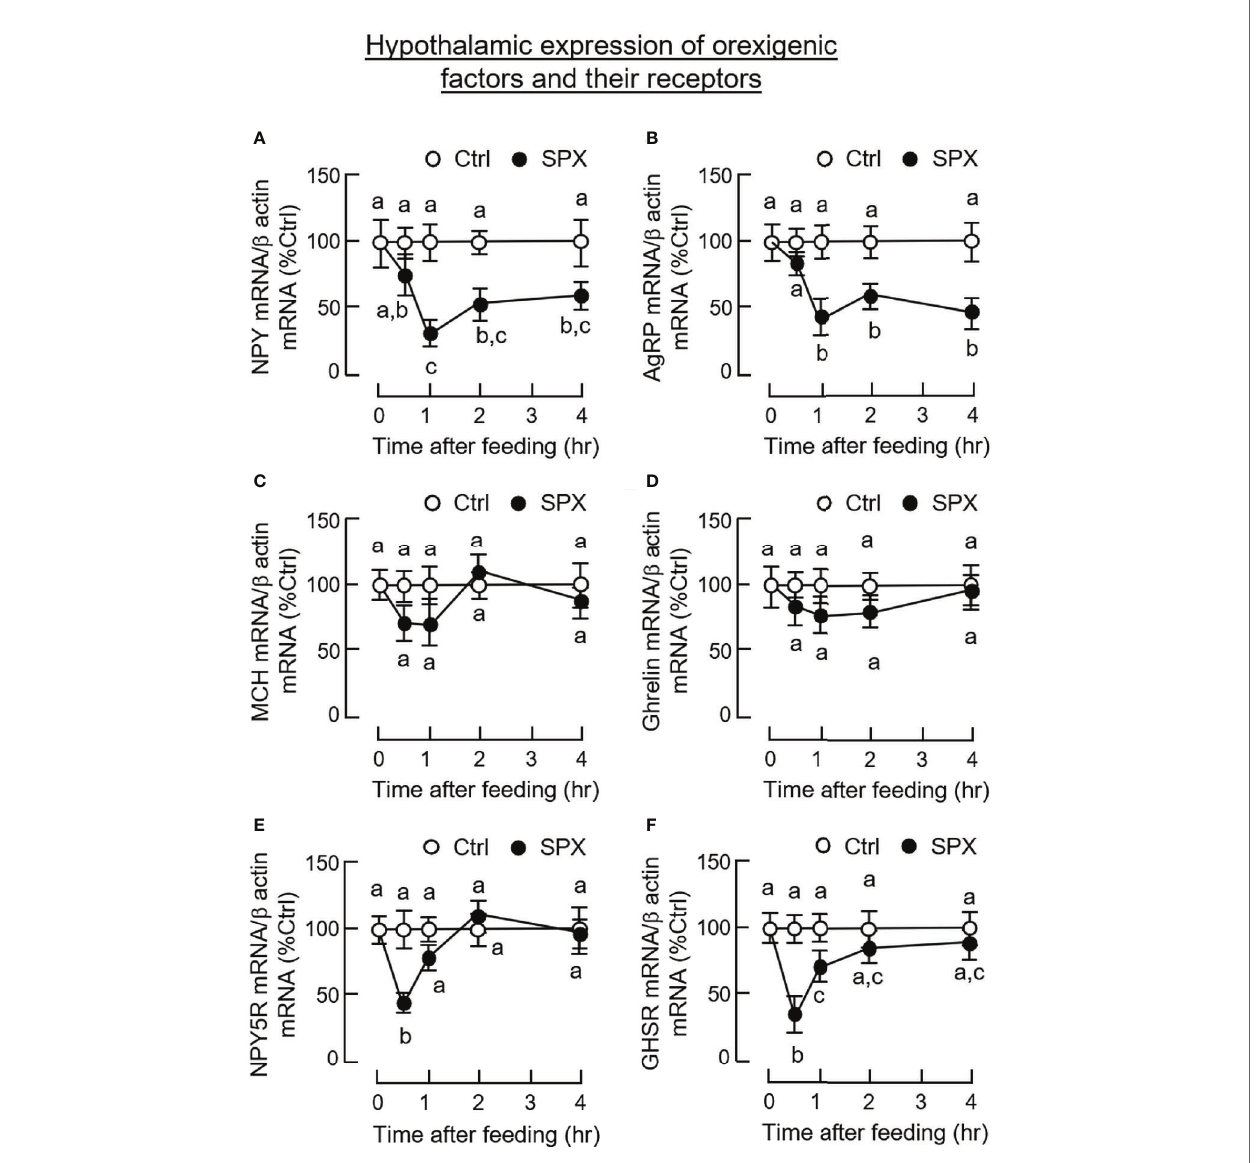
FIGURE 7 | Central administration of SPX on hypothalamic expression of orexigenic factors and their receptors. ICV injection of SPX (1 nmole/mouse) was conducted in mice with parallel injection of arti fi cial CSF as control treatment. The hypothalamus was harvested at the time points as indicated and used for total RNA isolation followed by real-time PCR for transcript expression of NPY (A) , AgRP (B) , MCH (C) , ghrelin (D) , NPY5R (E) and GHSR (F) , respectively. In this study, b actin mRNA was used as the internal control. The groups denoted by different letters represent a signi fi cant difference at p <